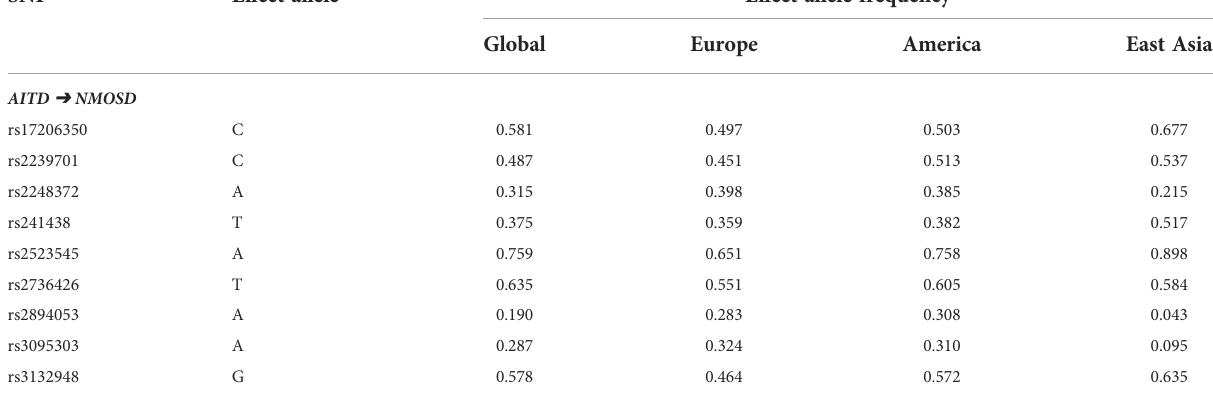
TABLE 2 Frequencies of causal SNPs of NMOSD on the exposure of autoimmune diseases based on regions. SNP Effect allele Effect allele frequency Global